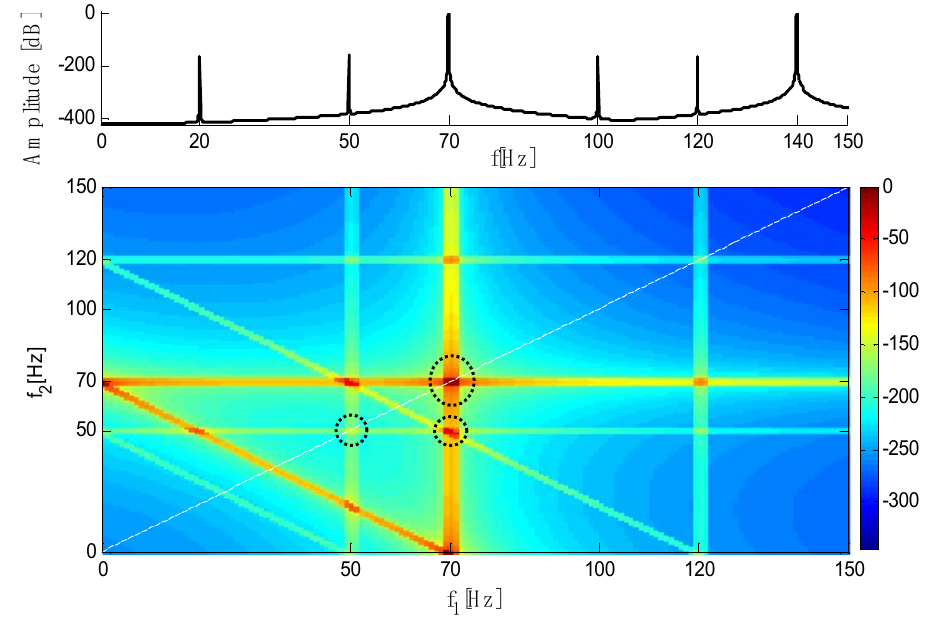
Figure 6. Power spectrum (PS; top panel) and bispectrum (bottom panel) of the nonlinear process given in Equation (11).